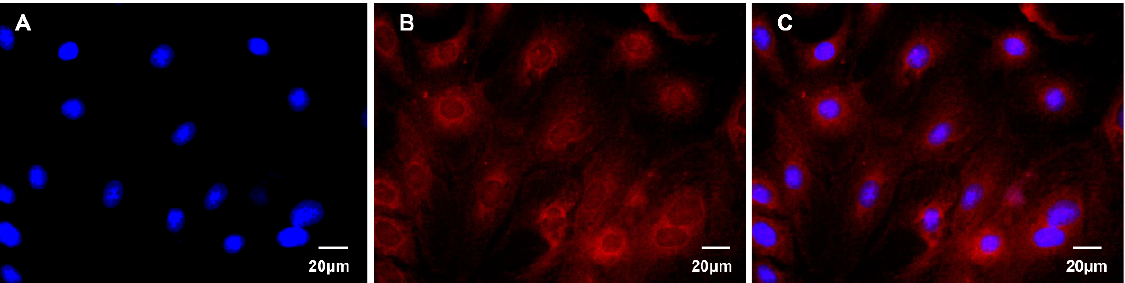
(Figure 1A). The CK-18 existed in the cytoplasm of the cells and was labeled with FITC (Figure 1B,C). Therefore, it was illustrated that the cells were bMECs.